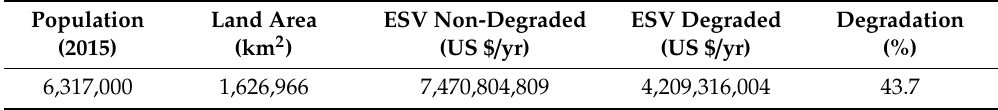
Table 15. The total terrestrial ecosystem services value (ESV) for Libya before and after land degradation (adapted from [54]).